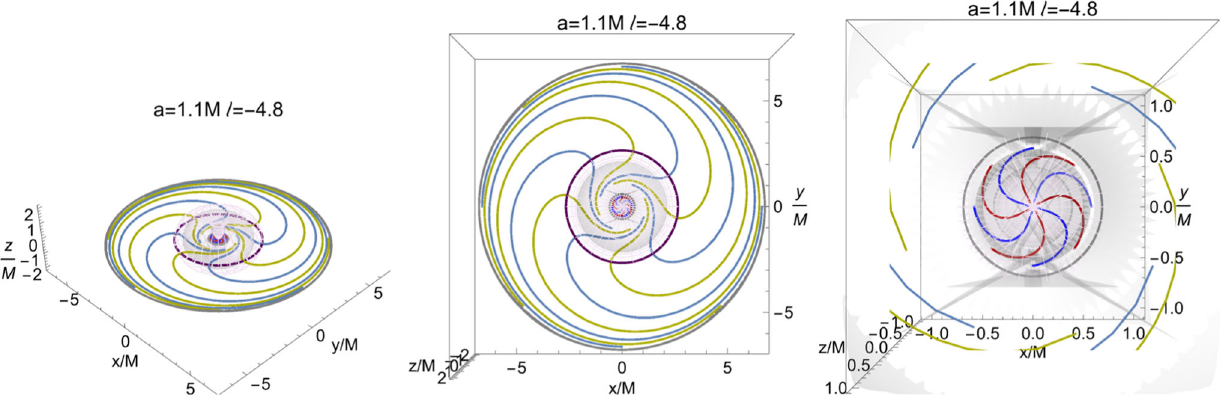
the light-purple surface. On the equatorial plane, radius r ± (cid:2) is the purple curve.Graysurfaceisthegeometryinnerandouterergosurfaces.Center panel is the above view of the left panel. Right panel is a close-up view of the center panel, where trajectories from the inner counter-rotating torus flow are